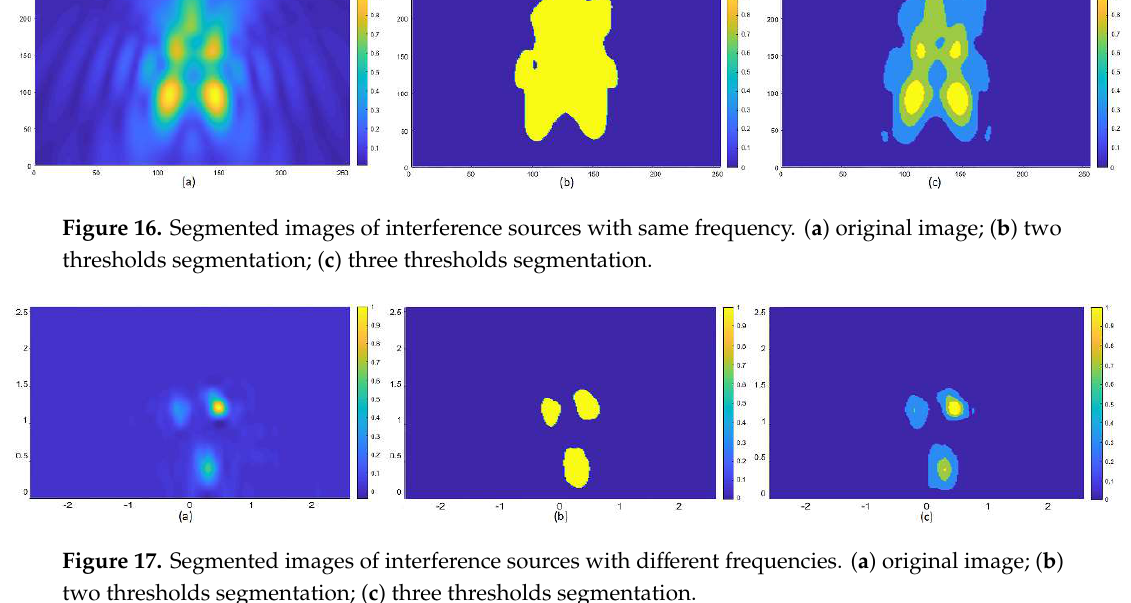
Table 1. Comparison among PNN, RBF and GRNN.